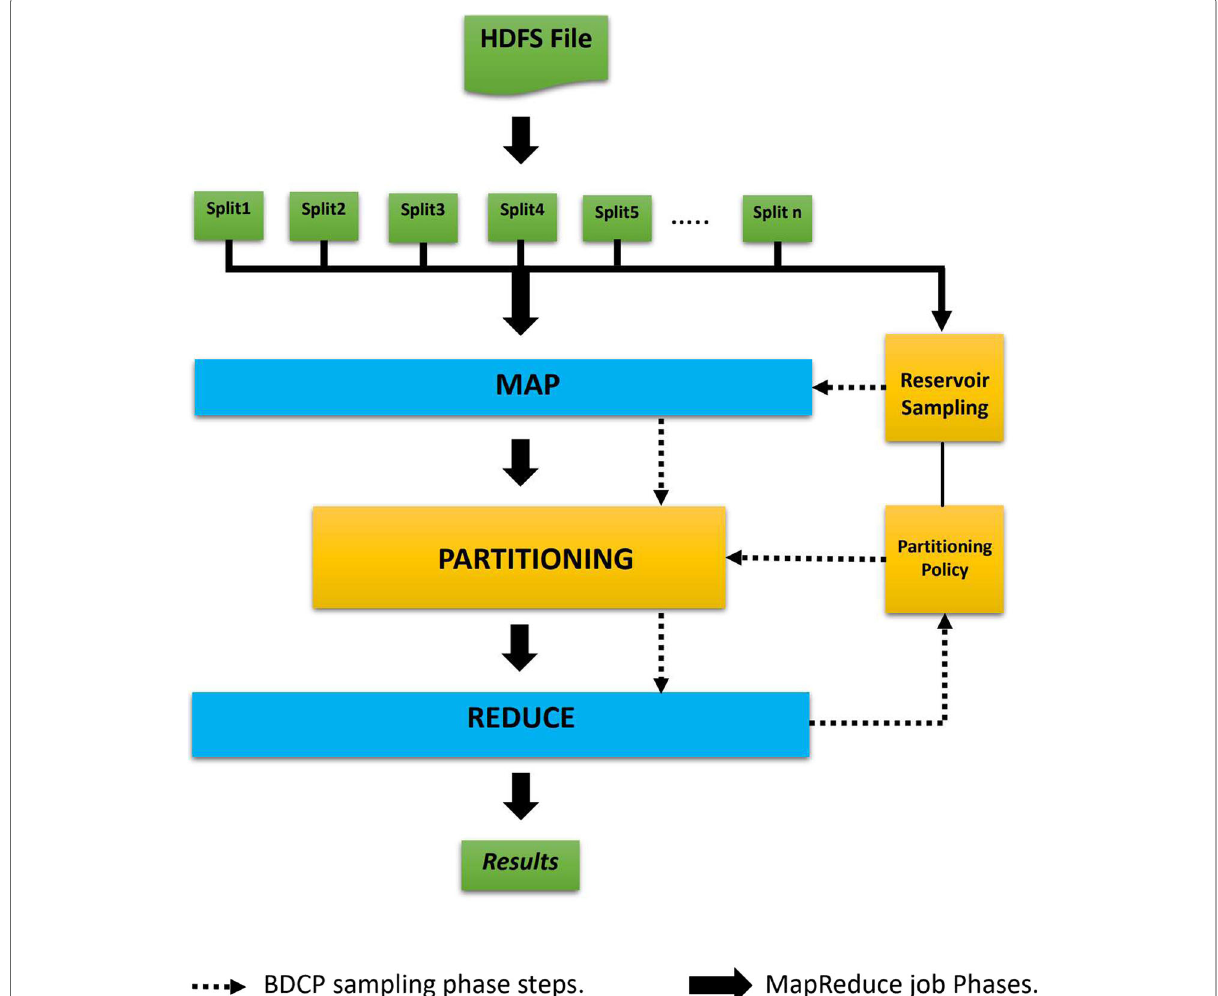
Fig. 3 MapReduce job with BDCP partitioning